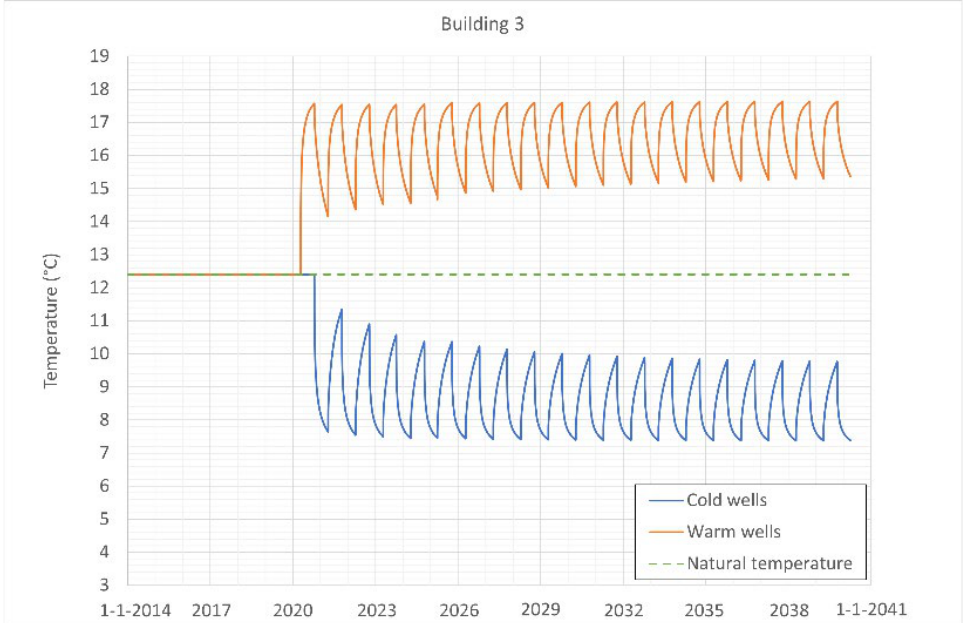
Figure 8. Simulated long-term evolution of the mean temperature at the hot and cold wells for Building 3.